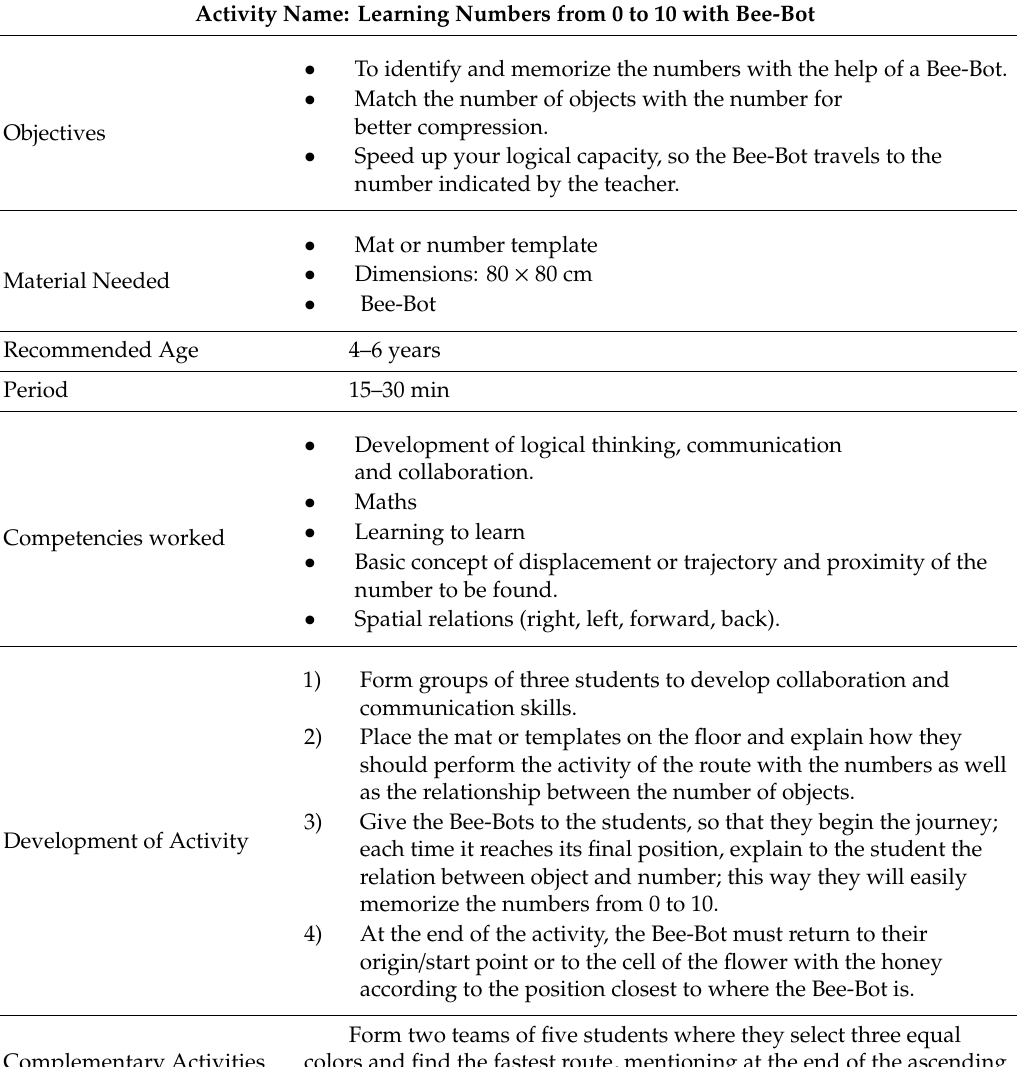
Table 1. Activity